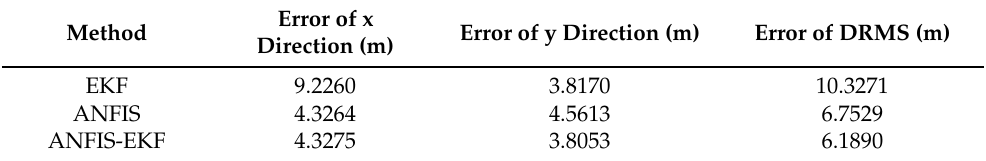
Figure 10. Performance analysis of ANFIS-EKF. ( a ) Positioning error comparison of x coordinate. ( b ) Positioning error comparison of y coordinate. ( c ) Estimated trajectories comparison. ( d ) Positioning error of DRMS. Table 4. Positioning errors comparison of three